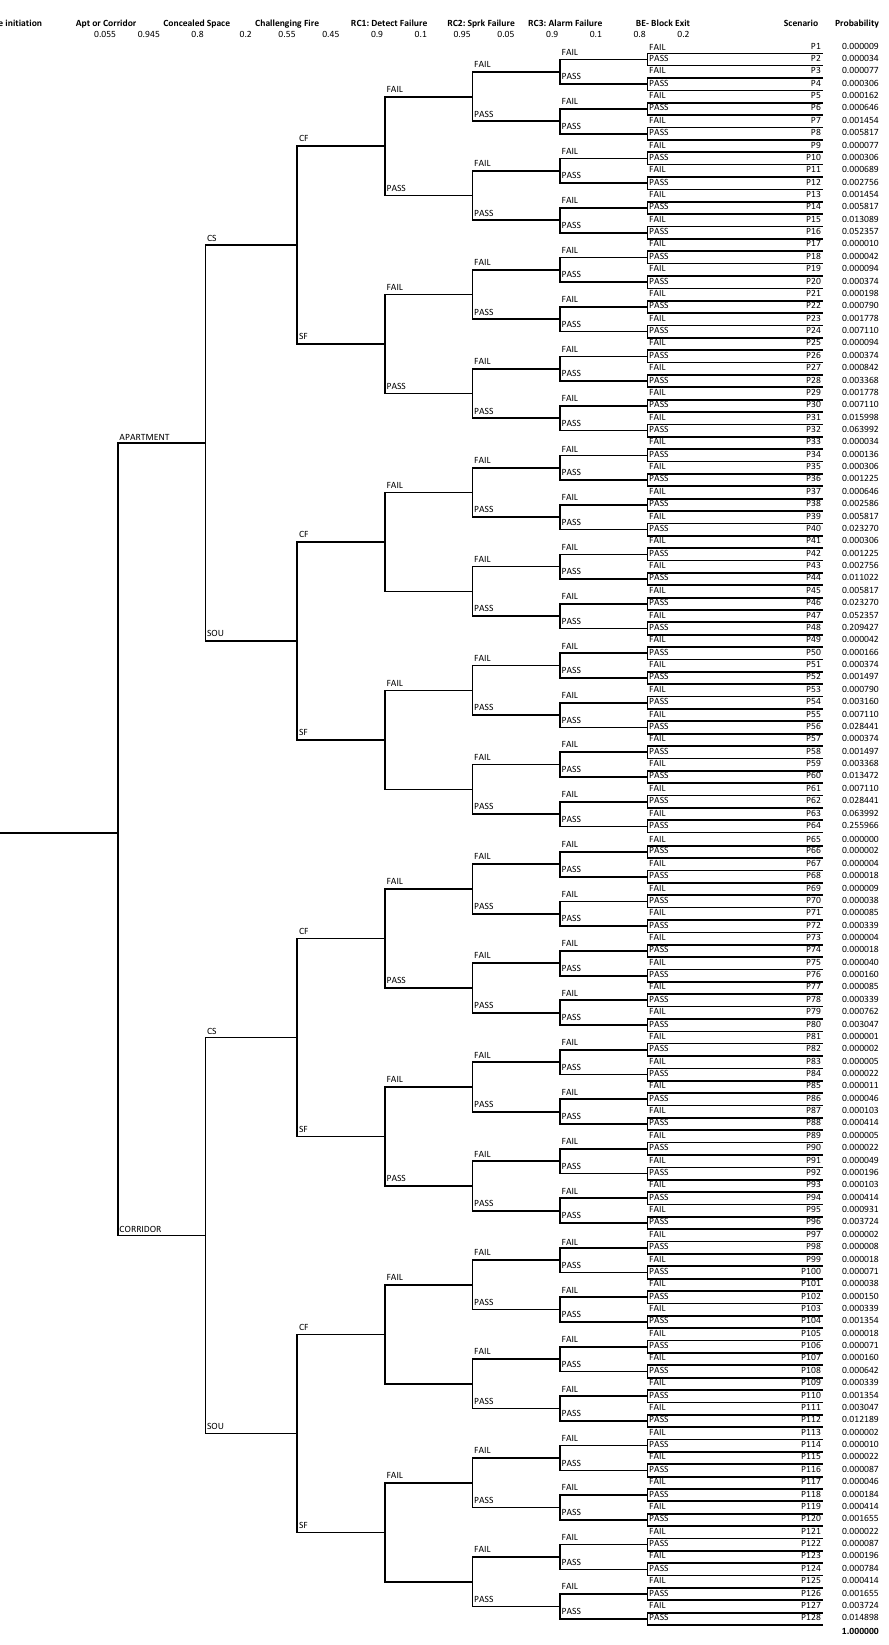
Figure A1. Example of a typical Event tree incorporating fire scenarios.